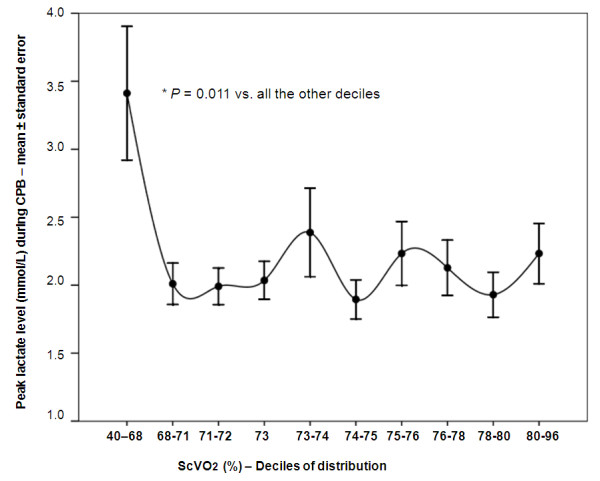
Peak whole blood lactate according to the nadir ScVO2 value. Significance assessed with the Kruskal-Wallis test.